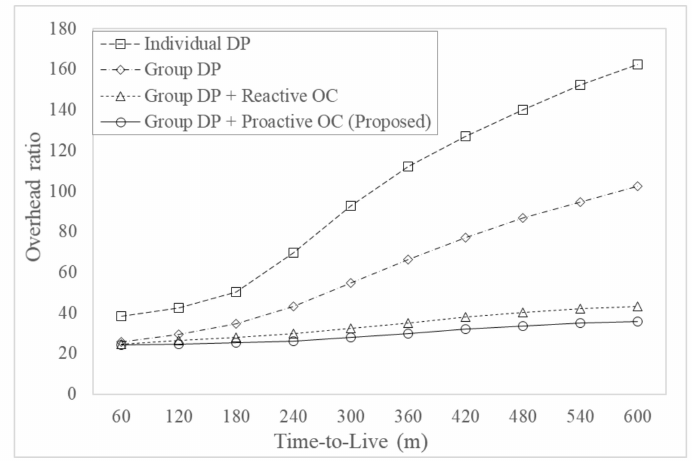
Figure 12. Overhead ratio for varying